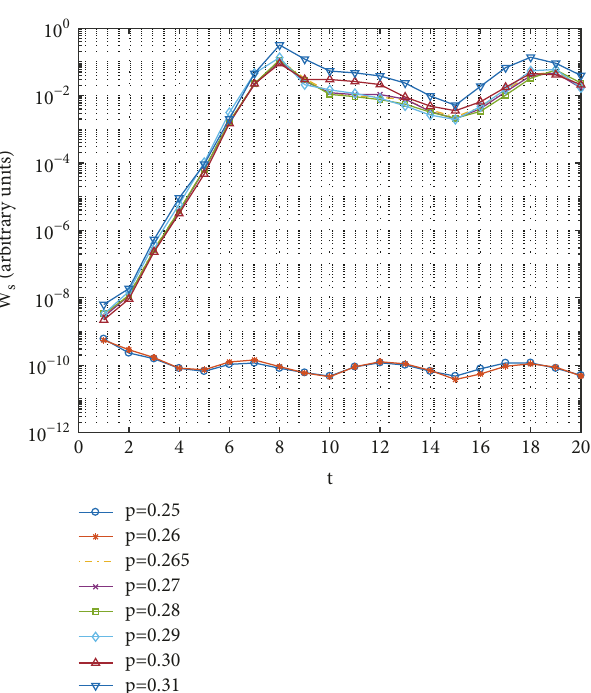
Figure 1: The specific energy 𝑊 𝑠 = 𝑊/𝑙 3𝑁 (arbitrary units) as functions of the time 𝑡 at various probability populations of percolating clusters 𝑝 = 0.25. .. 0.3 . We observe that a family 𝑊 𝑠 is well-separated in two completely different groups. In first group at 𝑝 ≤ 0.26 the energy 𝑊 𝑠 conserves the small initial values ∼ 10 −9 and practically is independent of time. However, in second group when 𝑝 ≥ 0.27.. .0.30 the values 𝑊 𝑠 (𝑡) increase very fast and attain maximal value 10 −1 at 𝑡 = 8 ; however, for longer time 𝑊 𝑠 (𝑡) oscillate around 10 −2 without a